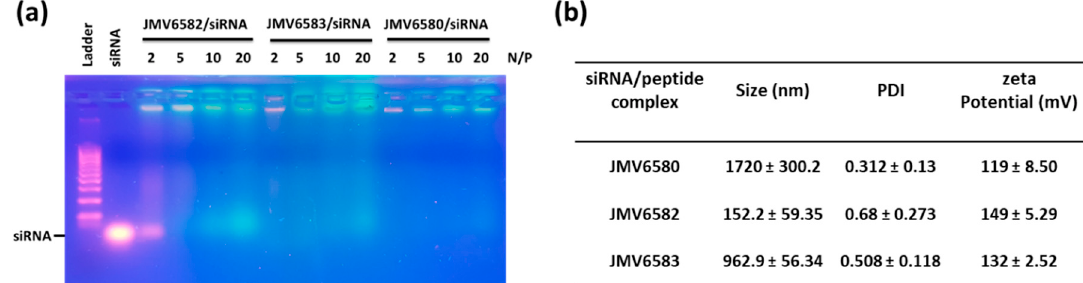
Figure 3. Studies of stapled peptides complexation with siRNA ( a ) Gel electrophoresis analysis for different stapled peptides at N/P = 2, 5, 10, and 20. ( b ) Physicochemical characterization (Particle size, polydispersity index (PDI) and ζ -potential measurements) of stapled peptide/siRNA complex at N/P = 2 for JMV6580 and JMV6583, and N/P = 5 for JMV6582. The values are represented as mean ± SD (n = 3).